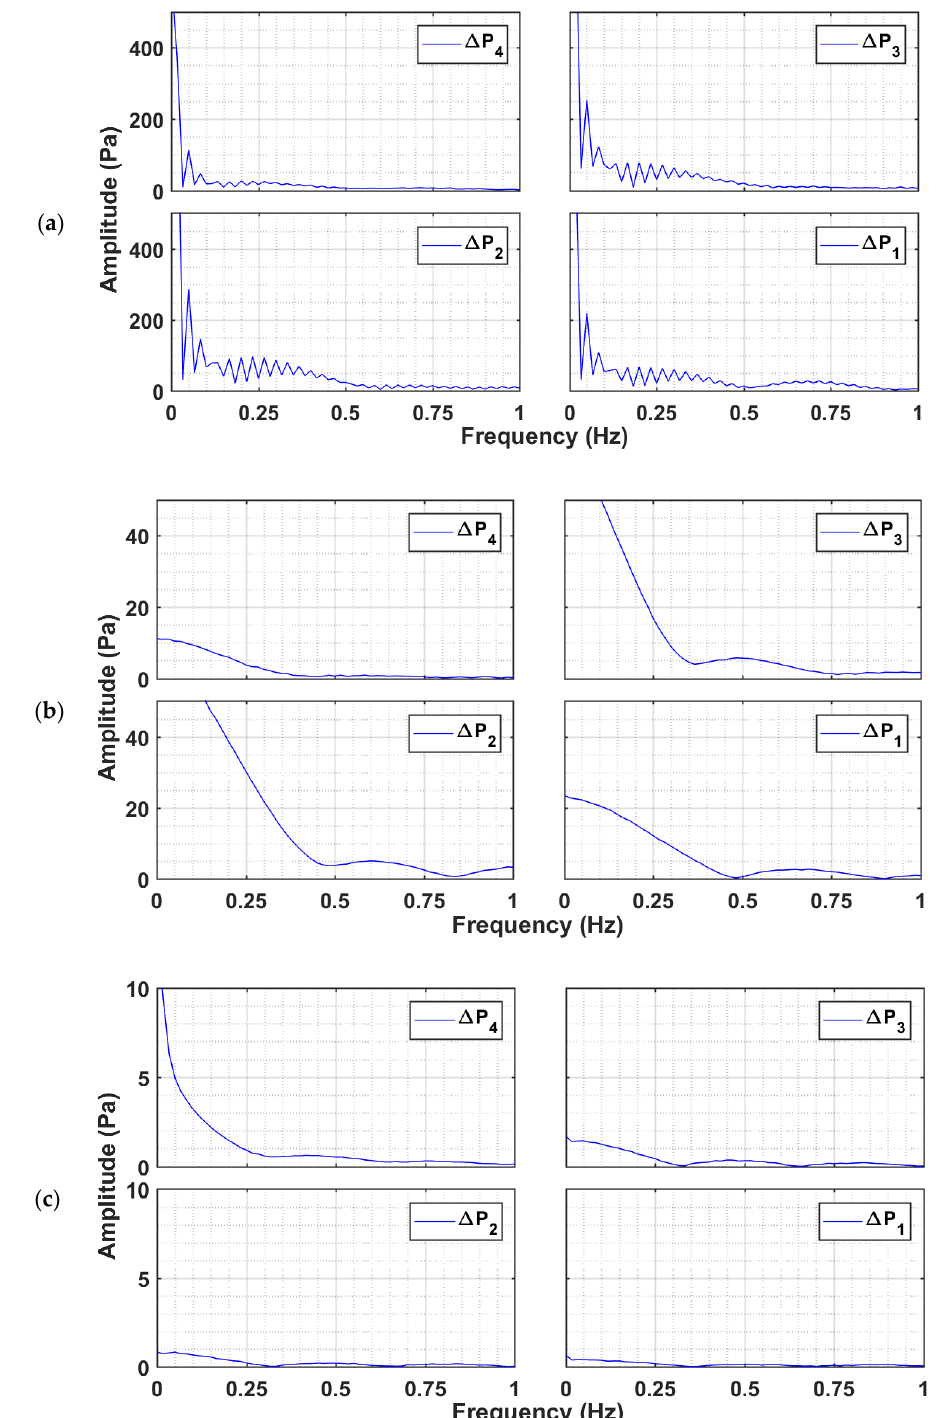
Figure 8. Power spectral analysis at low frequencies (0 – 1 Hz) of pressure transients in different bed regions of the collapsing bed at U mf and bed height H of ( a ) glass beads, ( b ) titania, and ( c ) regions of the collapsing bed at 𝑈 𝑚𝑓 and bed height H of ( a ) glass beads, ( b ) titania, and ( c ) nanosilica.